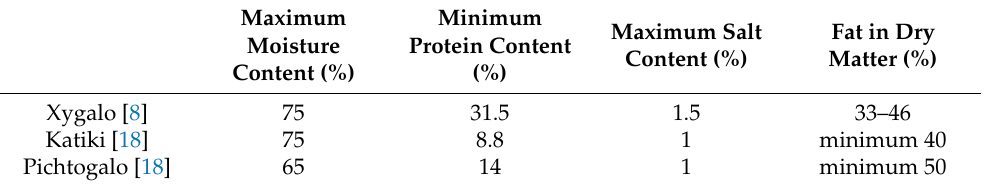
Table 2. Comparison of Xygalo Siteias, Katiki Domokou and Pichtogalo Chanion